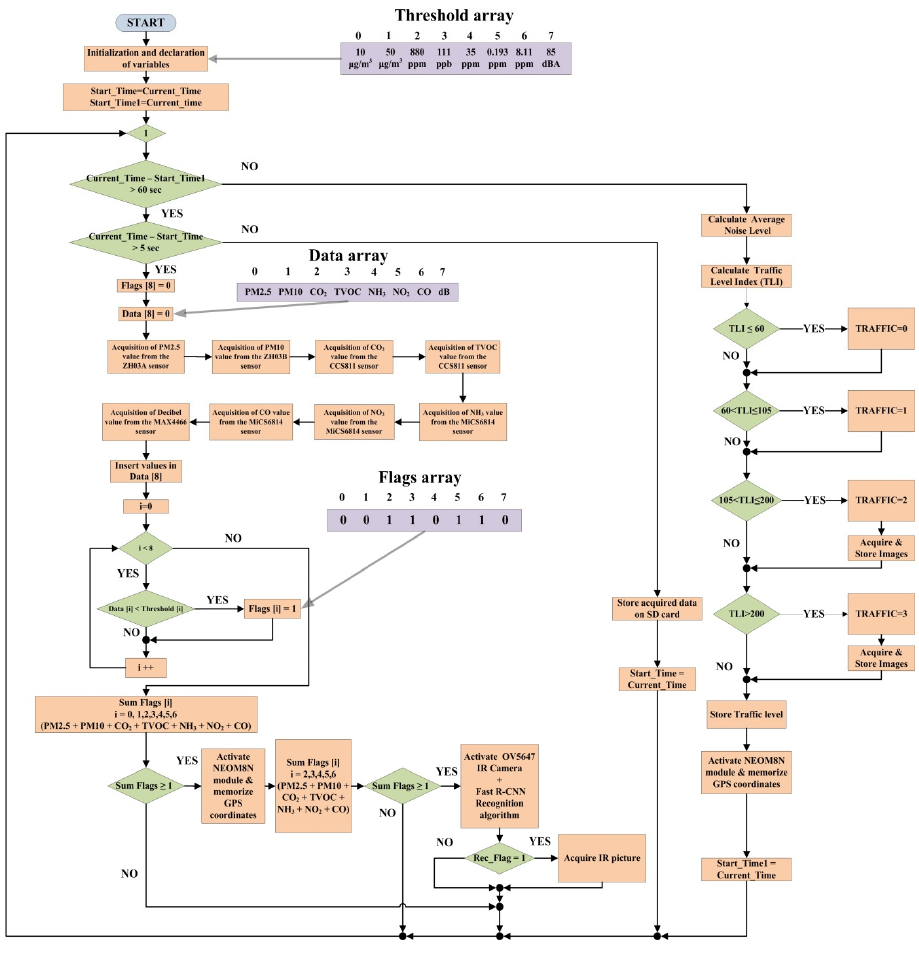
Figure 4. Flowchart of the firmware executed the sensor-based drone for pollutants detection and waste fire localization.